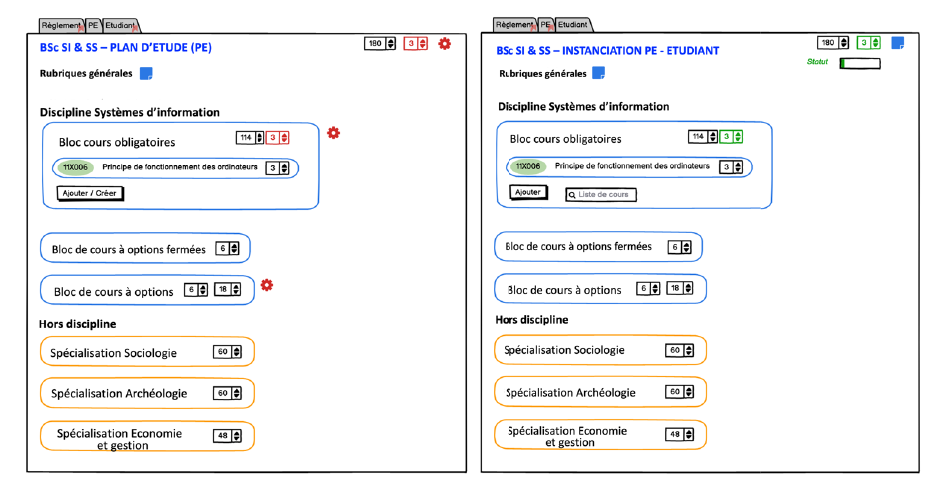
Figure 6: Mockup - Study Plan (left) and Student Personalised Program